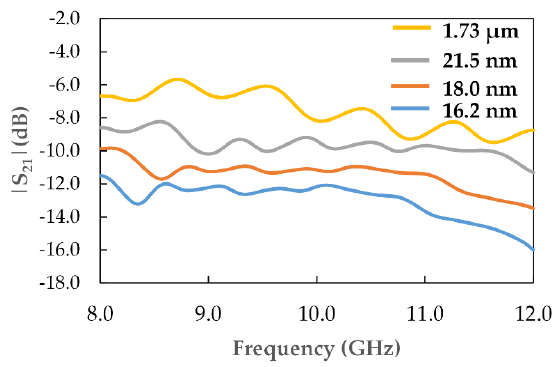
Figure 11. | S 21 | (dB) for di ff erent recycled α -Fe 2 O 3 particles as a function of frequency. Figure 11. |S 21 | (dB) for different recycled α -Fe 2 O 3 particles as a function of frequency .